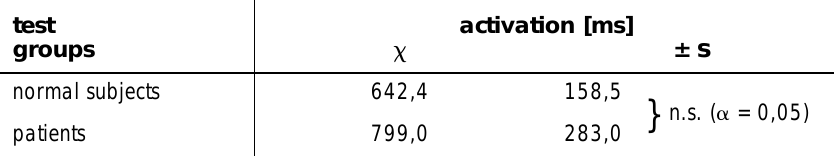
Table 1: Mean duration of activation in anteversion of the arm.